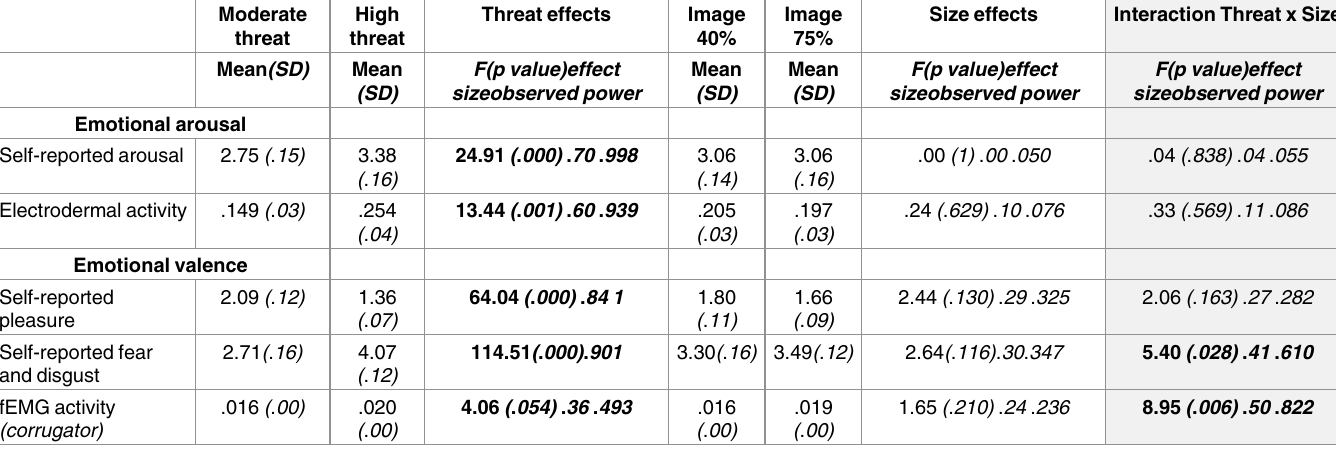
Table 3. Effects of threat level and image size on emotional